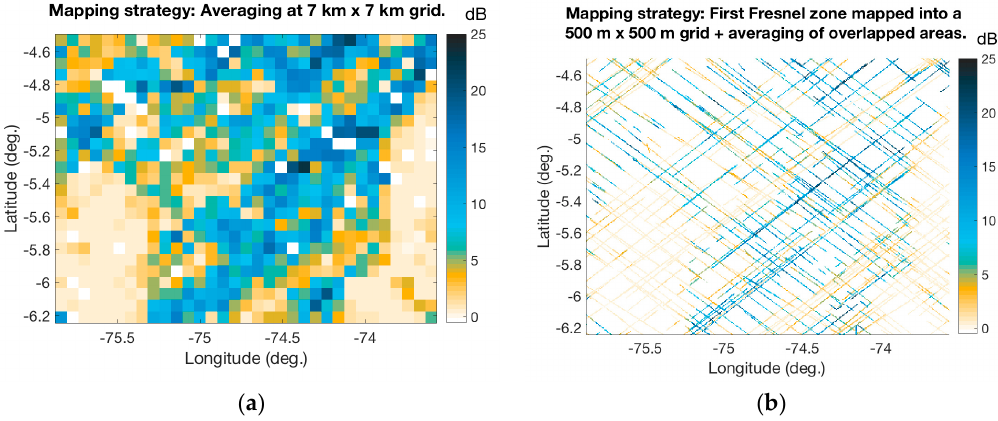
Figure 2. Comparison of two different gridding strategies considered for CYGNSS data over Pacaya-Samiria for a 14 day period from 8–21 May 2017: ( a ) fixed spatial resolution set to 7 km × 7 km, where each grid cell represents the averaged power of all reflection signals with specular points falling within each cell. ( b ) Fixed spatial resolution set to approximately 500 m × 500 m, such that the first Fresnel zone ellipse of each single measurement is mapped across multiple grid cells.